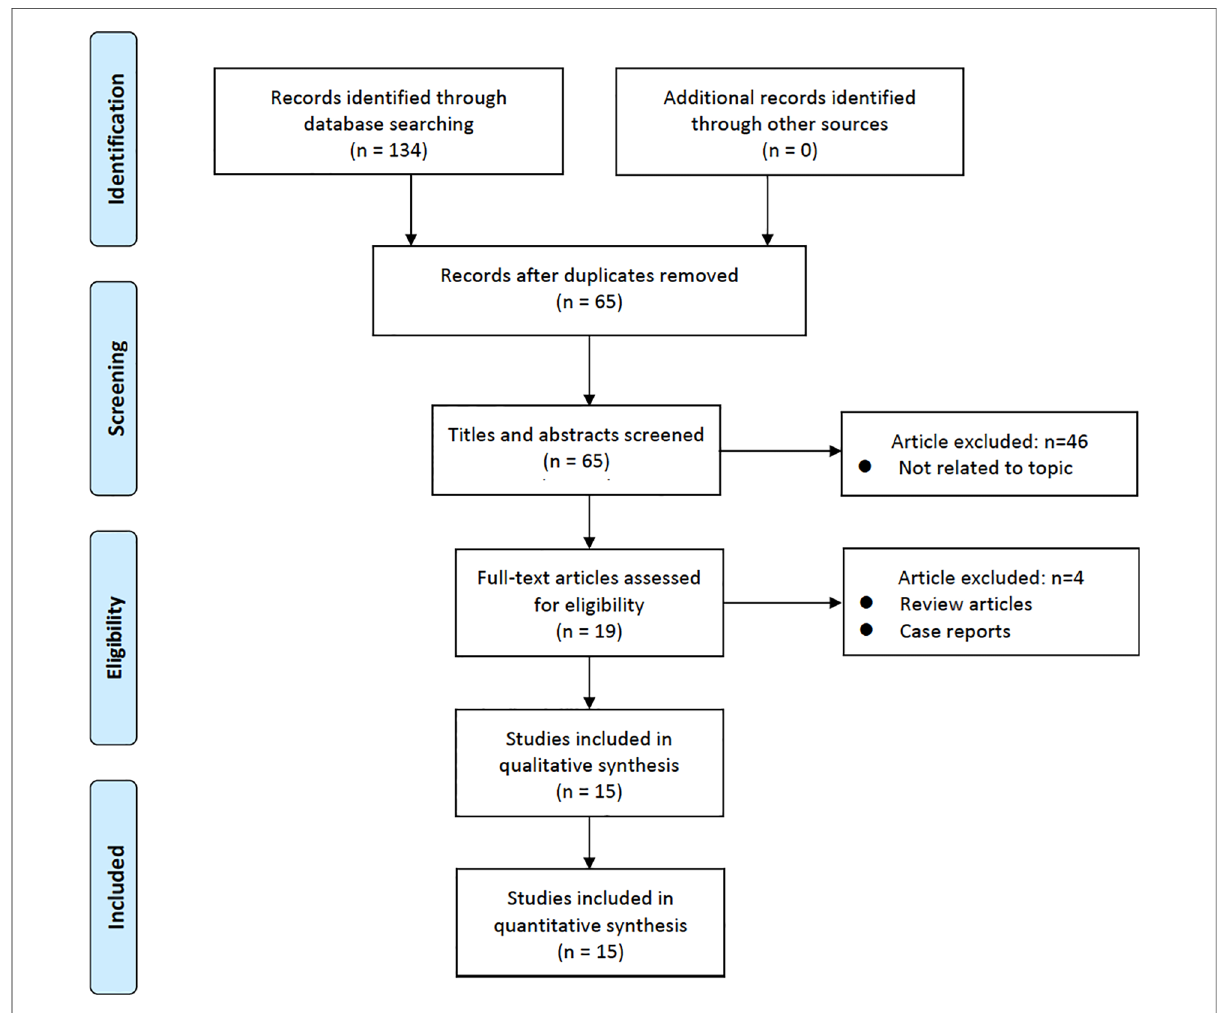
FIGURE 1 Study selection fl ow diagram for the